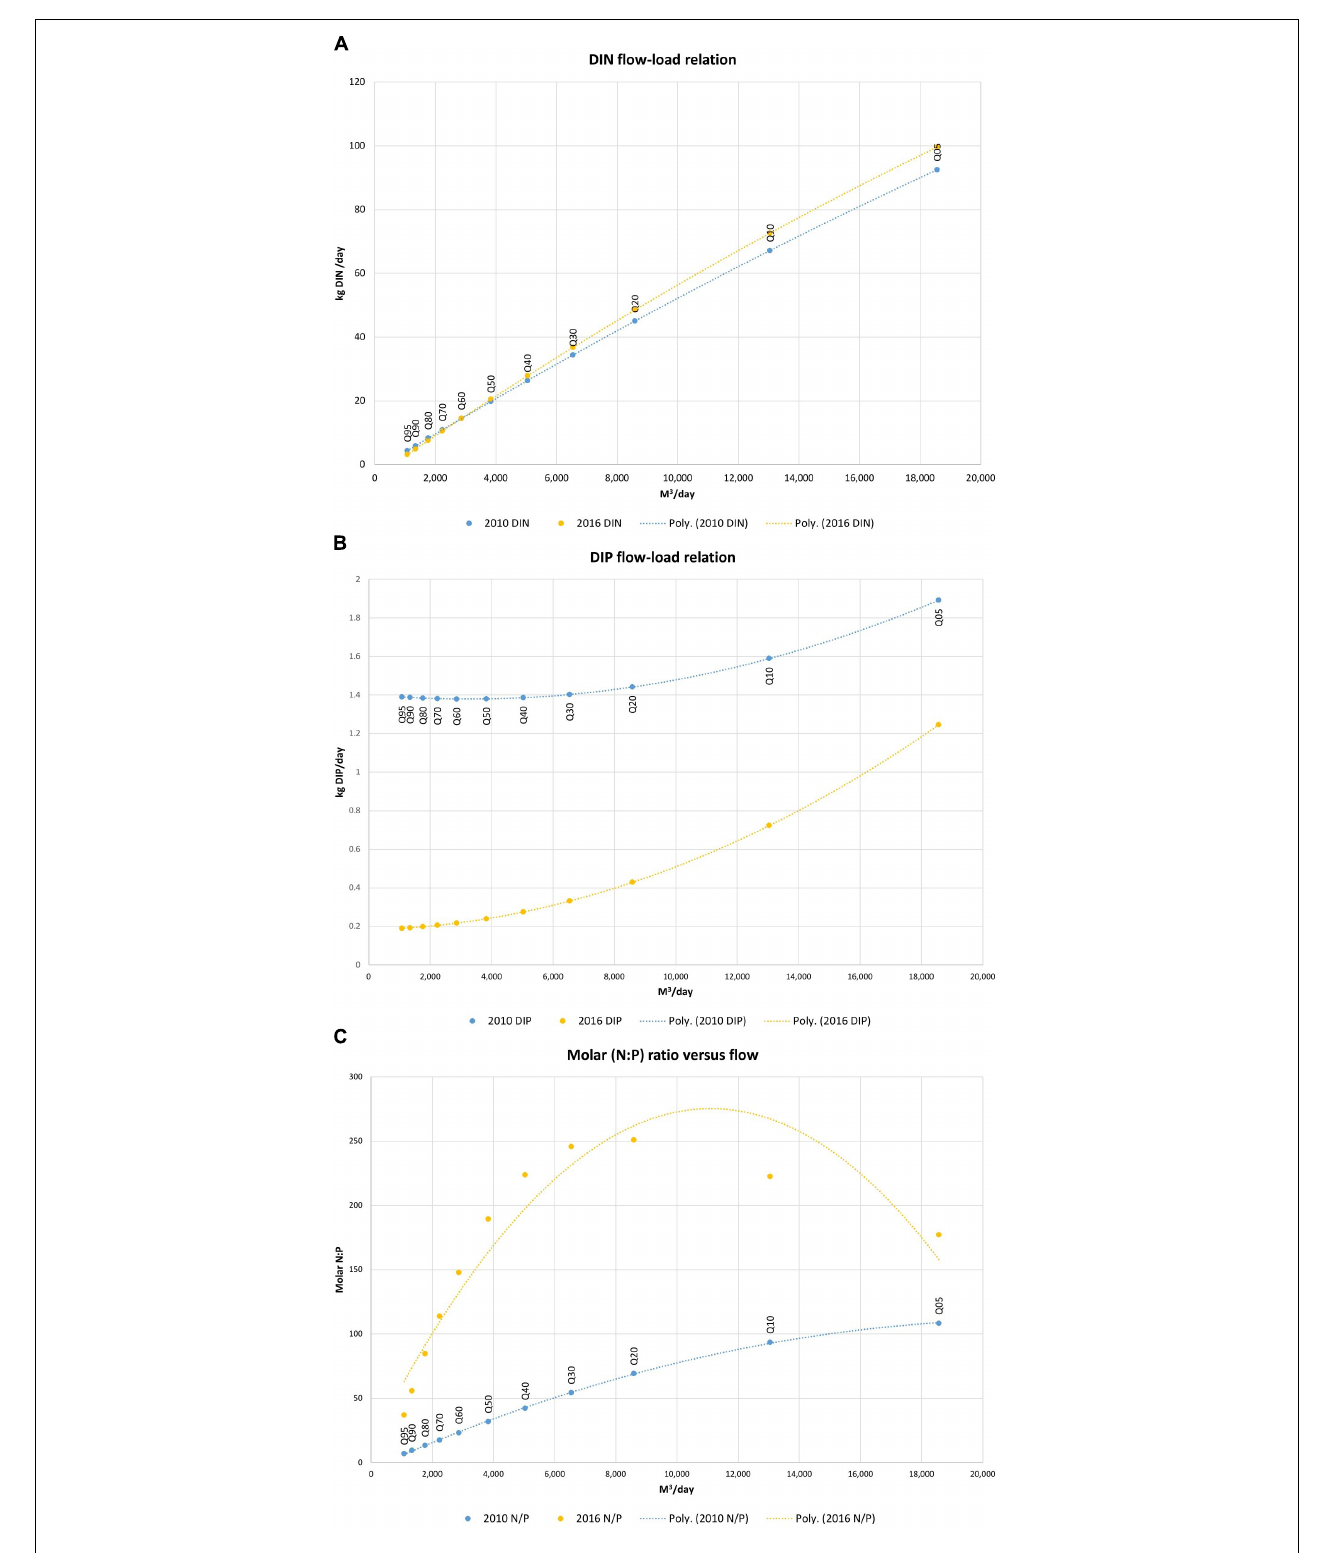
FIGURE 5 | (A) Summer DIN flow-load relation, (B) Summer DIP flow-load relation, and (C) Summer molar N: P ratio vs. flow; flow values are long term summer flow percentiles Q 05 - Q 95